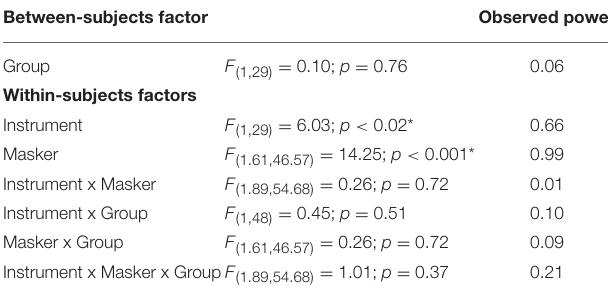
FIGURE 4 | The average percentage correct scores for the melodic contour identification for the piano (left) and organ (right) shown for both groups. From left to right in each panel the masker is shown: no masker, A3 overlapping pitch masker, A5 non-overlapping pitch masker. The box descriptions are similar to those of Figure 2 . The thick horizontal line represents chance level. TABLE 4 | The results of the split-plot repeated measures ANOVA for